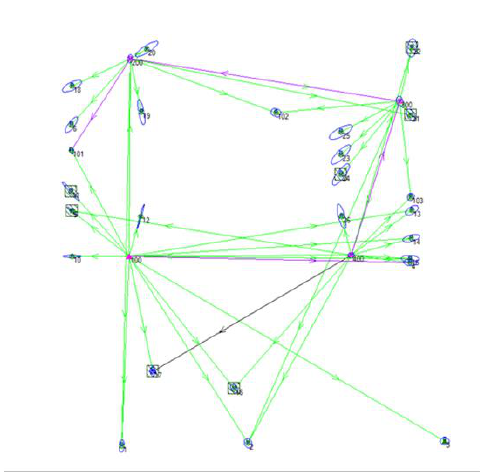
Figure 3. The network around the building. A set of scans was then collected with a Faro Focus 3D HDR X130, using a resolution of 44 million points / scan. Scans were taken moving the scanner around the building. Registration was carried out using the checkerboard targets already measured with the total station, and additional sphere-to-sphere correspondences used to connect consecutive scans. The registration gave an average precision of about ±2-3 mm, which seems sufficient for the next phases of the work, i.e. the evaluation of chimney verticality. Some images of the registered point clouds are shown in Figure 4.